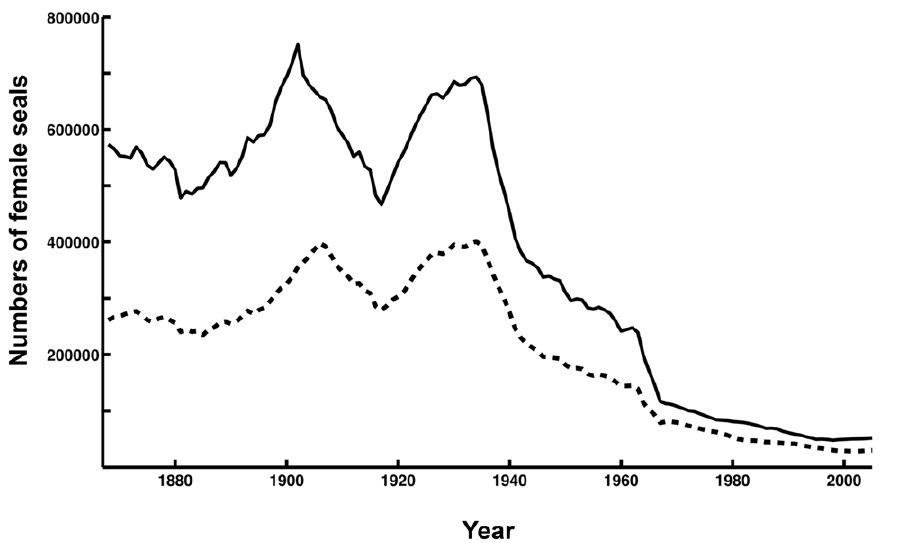
Figure 2. Estimated minimum total female population size (solid line) and the number adult females (dashed line) in the Caspian for the period 1867–2005 as based on historical hunting records (Fig. 1). The hunt during the 1960s led to a rapid decline in population size.